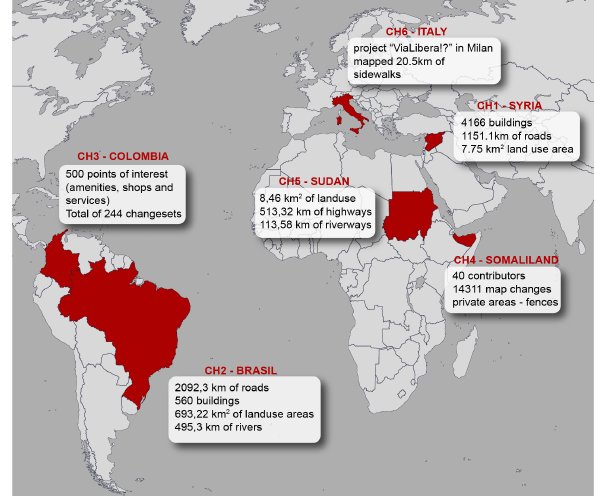
Figure 8. Location and details of the projects proposed to the